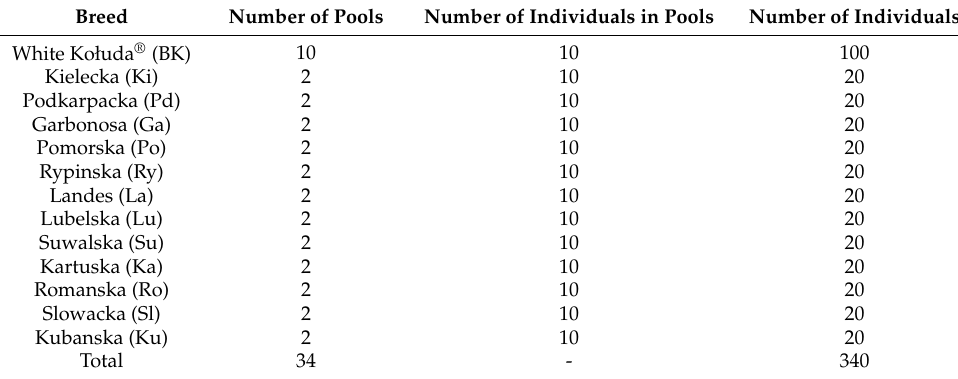
Table 1. DNA pools prepared for the experiment.